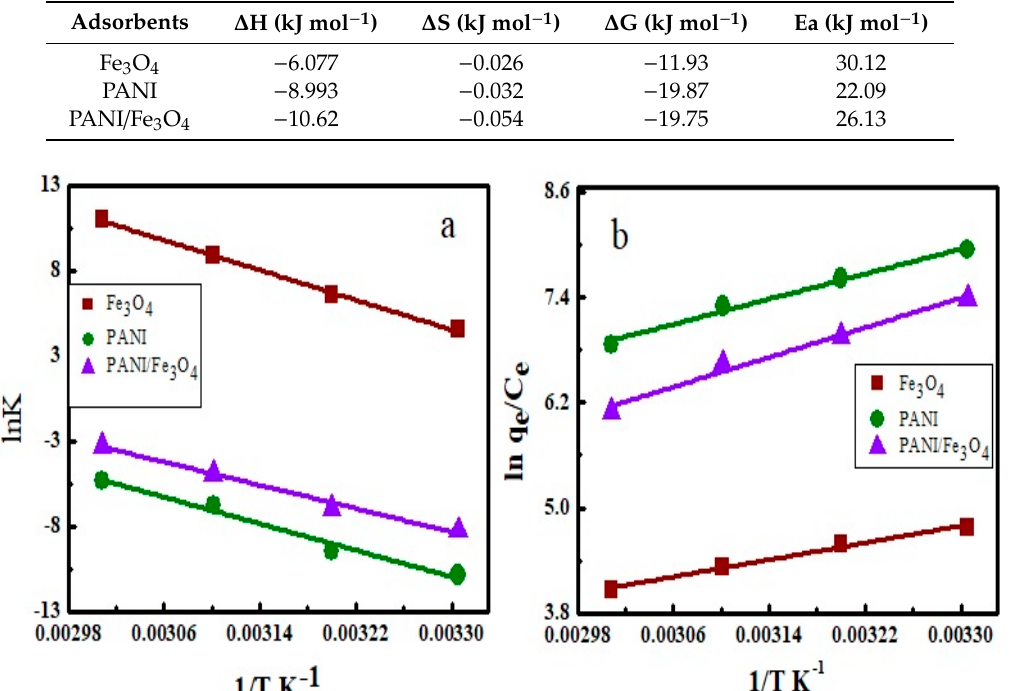
Figure 12. ( a ) Arrhenius plot and ( b ) van’t Hoff plot for calculation of activation energy and thermodynamic thermodynamic parameters . Table 5. Activation energy and thermodynamic parameters of AB40 adsorption .